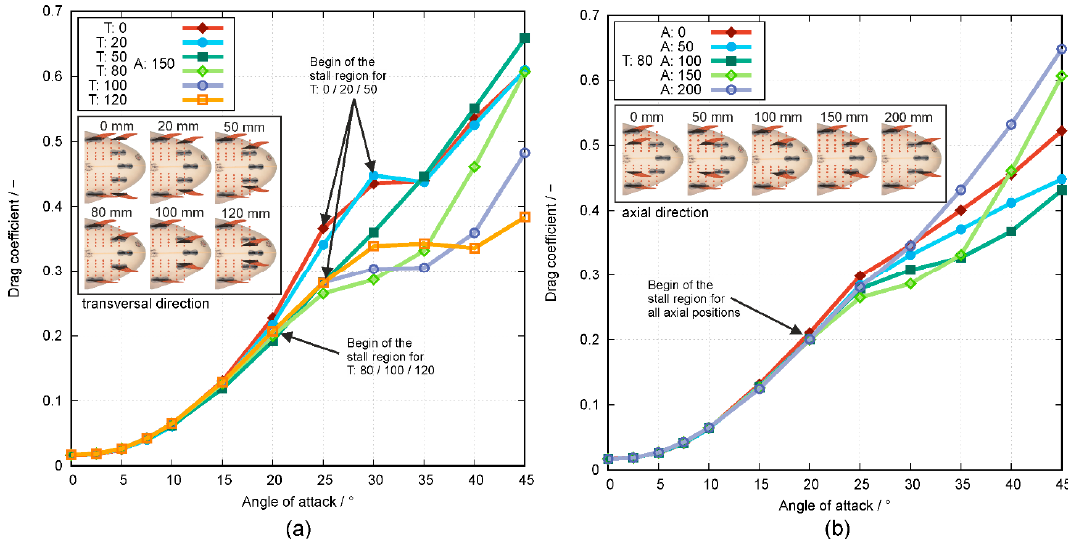
Figure 15. ( a ) Mean drag coefficients versus the angle of attack for six entire fin configurations. The rear fins are fixed in one axial position and shifted for six positions of the transversal direction of the surfboard. ( b ) Mean drag coefficients versus the angle of attack for five entire configurations. The rear fins are fixed in one transversal position and shifted for five positions of the axial direction of the surfboard.